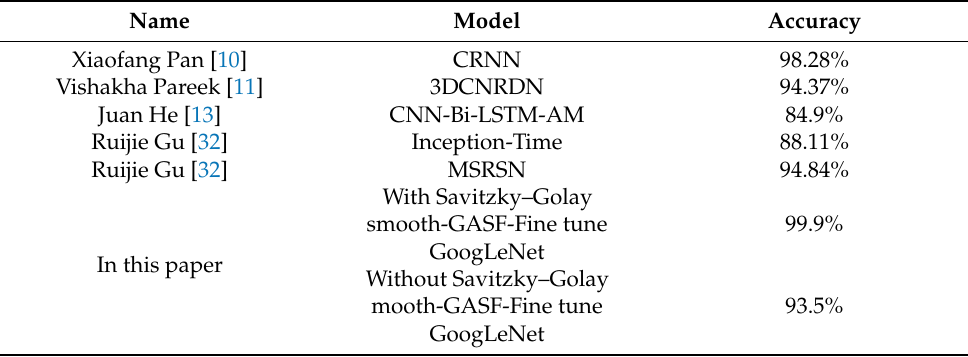
Table 8. Performance of accuracy compared with other people’s